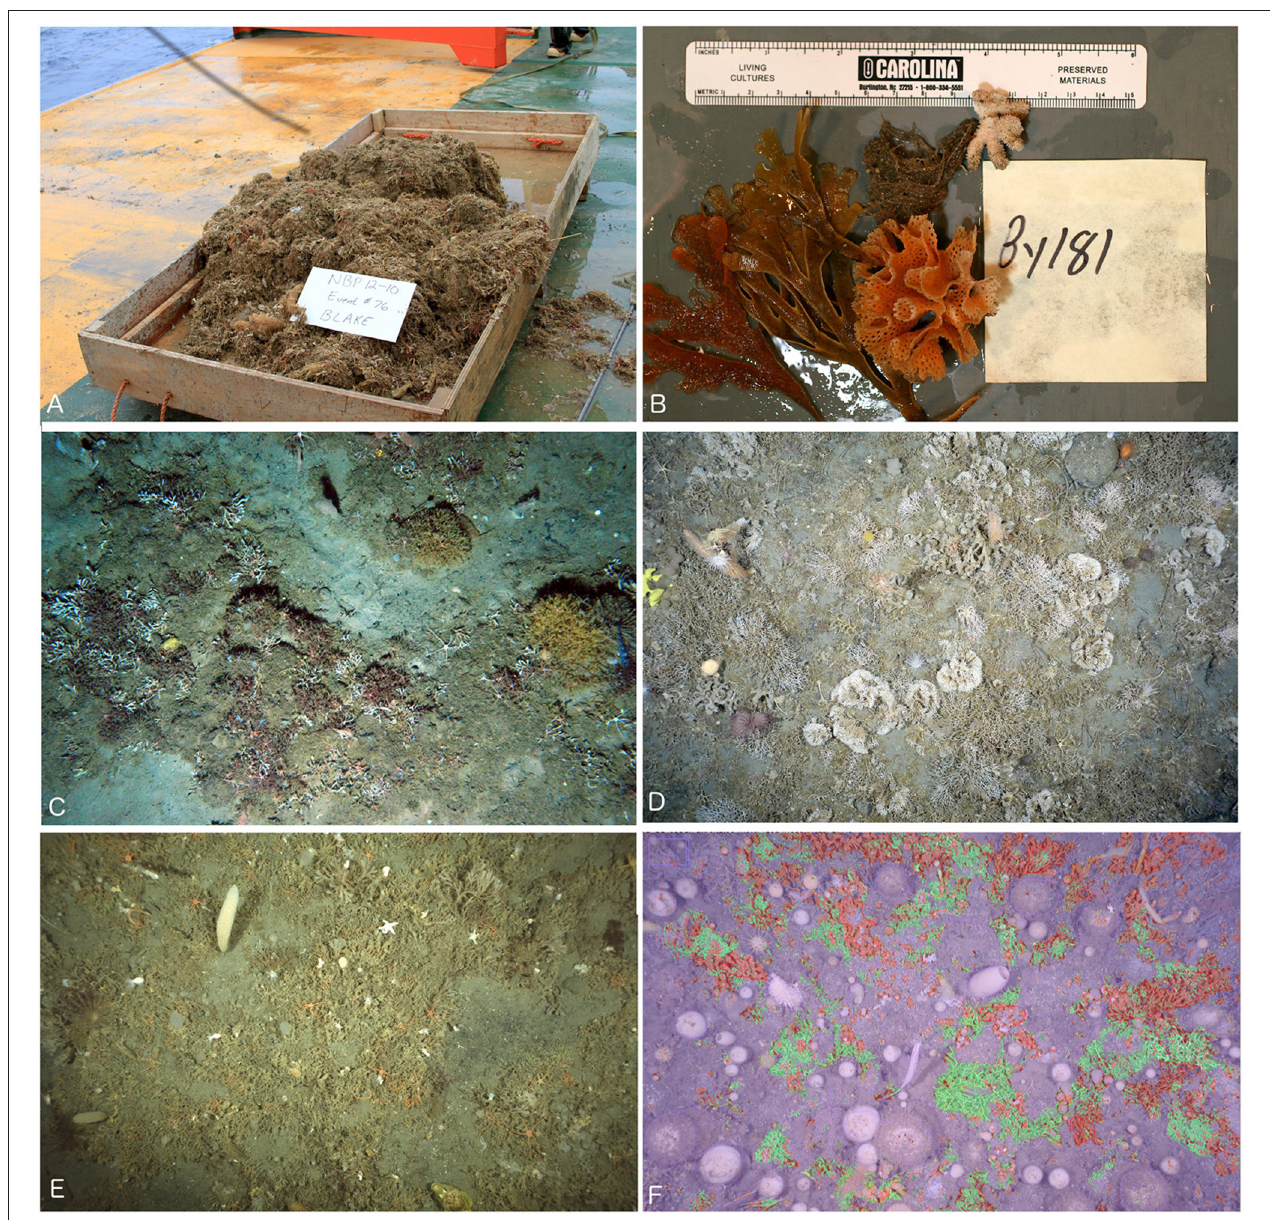
FIGURE 2 | Overview of bryozoan colony types and habitats. (A) Blake trawl gathered from the Ross Sea containing mainly flustrid bryozoans. (B) Typical flustrid, lepraliomorph, and umbonulomorph colony types. (C) Habitat-forming bryozoan communities of the Ross Sea. (D) Habitat-forming bryozoan communities of the Weddell Sea. (E) Habitat-forming bryozoan communities of the Scotia Sea. (F) Segmented image where flustrids are shaded red, lepralio-umbonulomorphs are shaded green, and the background substrate and other taxa are shaded